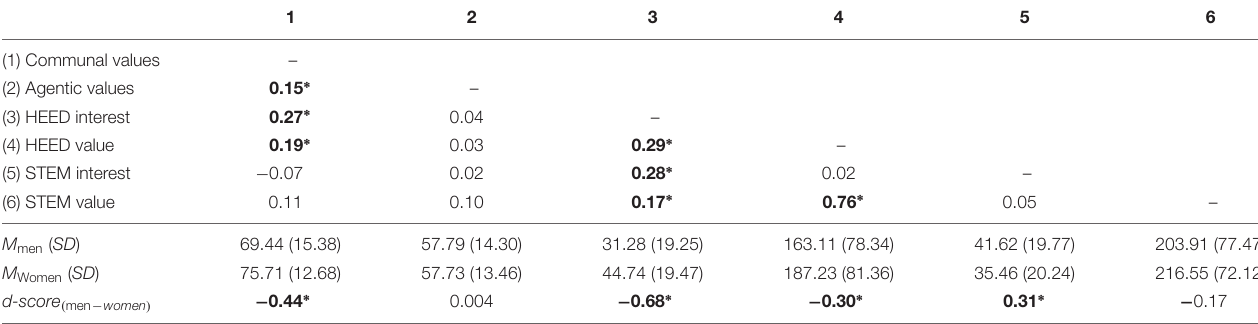
TABLE 1 | Study 1 descriptive statistics and bivariate